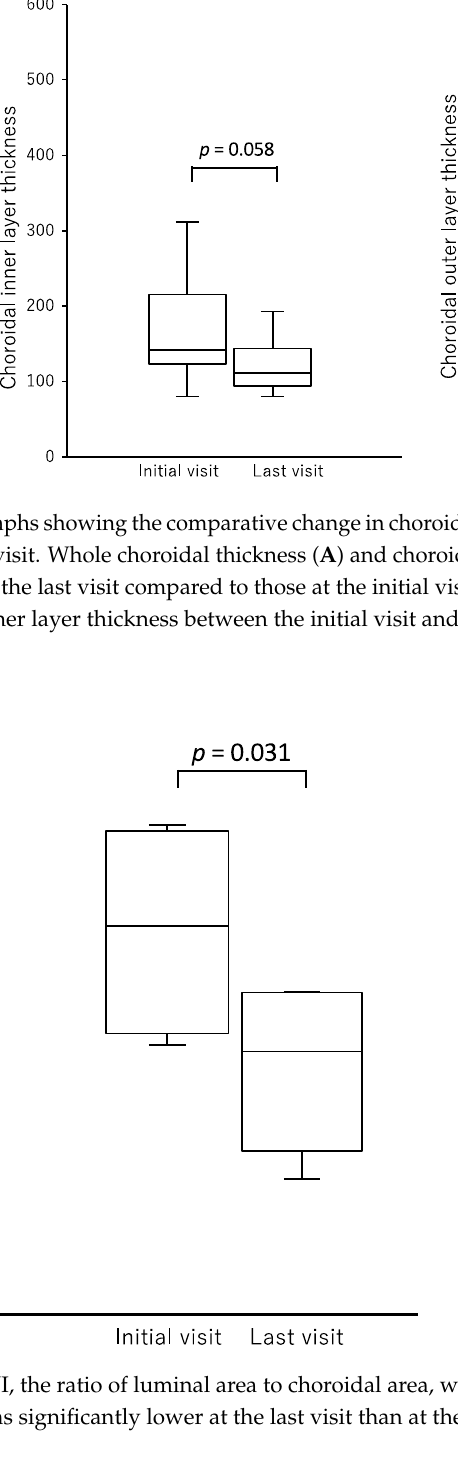
Figure 4. Images showing the findings in a typical case, i.e., a 31-year-old female patient who un- derwent a scheduled cesarean section at 33 weeks and 2 days and presented at the Department of